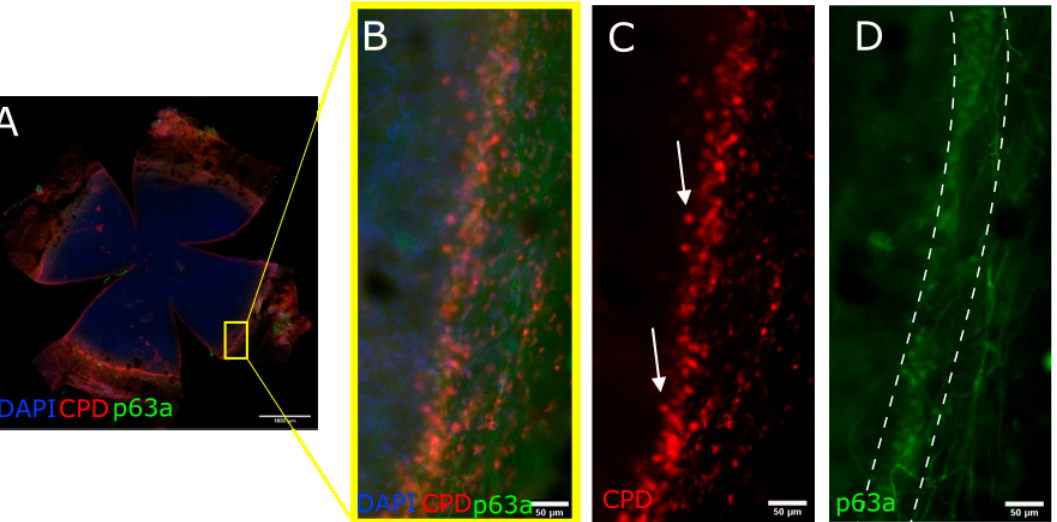
Figure 8. Images illustrating CPD recovery in CPDPL mutant mice following UVB exposure and 30 min photorecovery. CPDs stained with Alexa555 (( A – C ) shown here in red) and stem cell marker p63a stained with Alexa488 (( A , B , D ) shown here in green). Cells positive for CPDs inside the limbus are indicated by arrows in ( C ). Images were taken after 1 J/cm 2 UVB 30 min photorecovery. CPD immunofluorescence was particularly concentrated in limbal region and generally absent in central cornea.